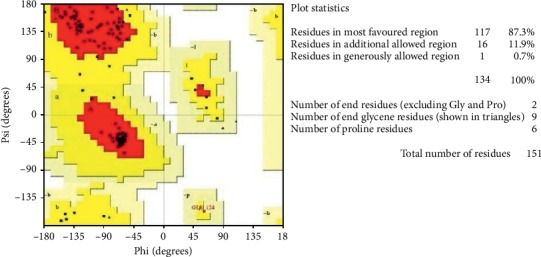
Stereochemical analysis of MLAAA-42. The red region declares the most favorable area of residues; the yellow region is additionally allowed; and generously allowed residues in the light-yellow region. The RC plot declares 99.2% of residues falling in the allowed region.